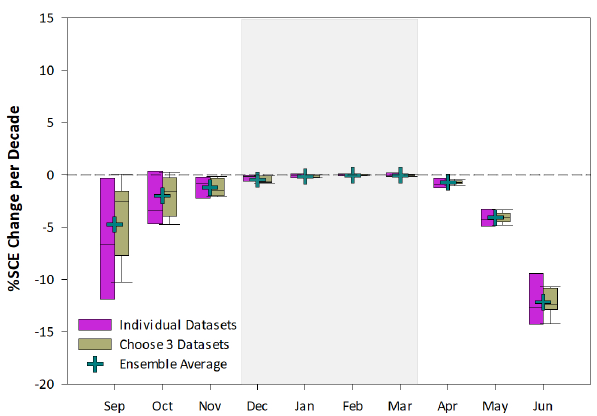
Figure 6. The impact of dataset averaging (new product set) on rates of change in Arctic